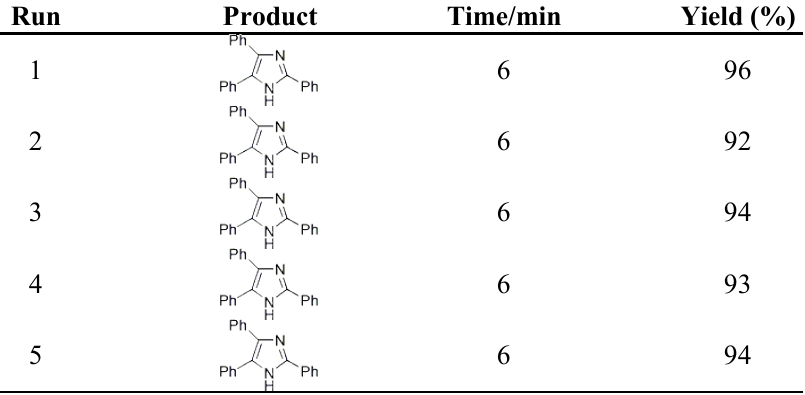
Recovery of zeolite in the synthesis of 2, 4, 5- trisubstituted